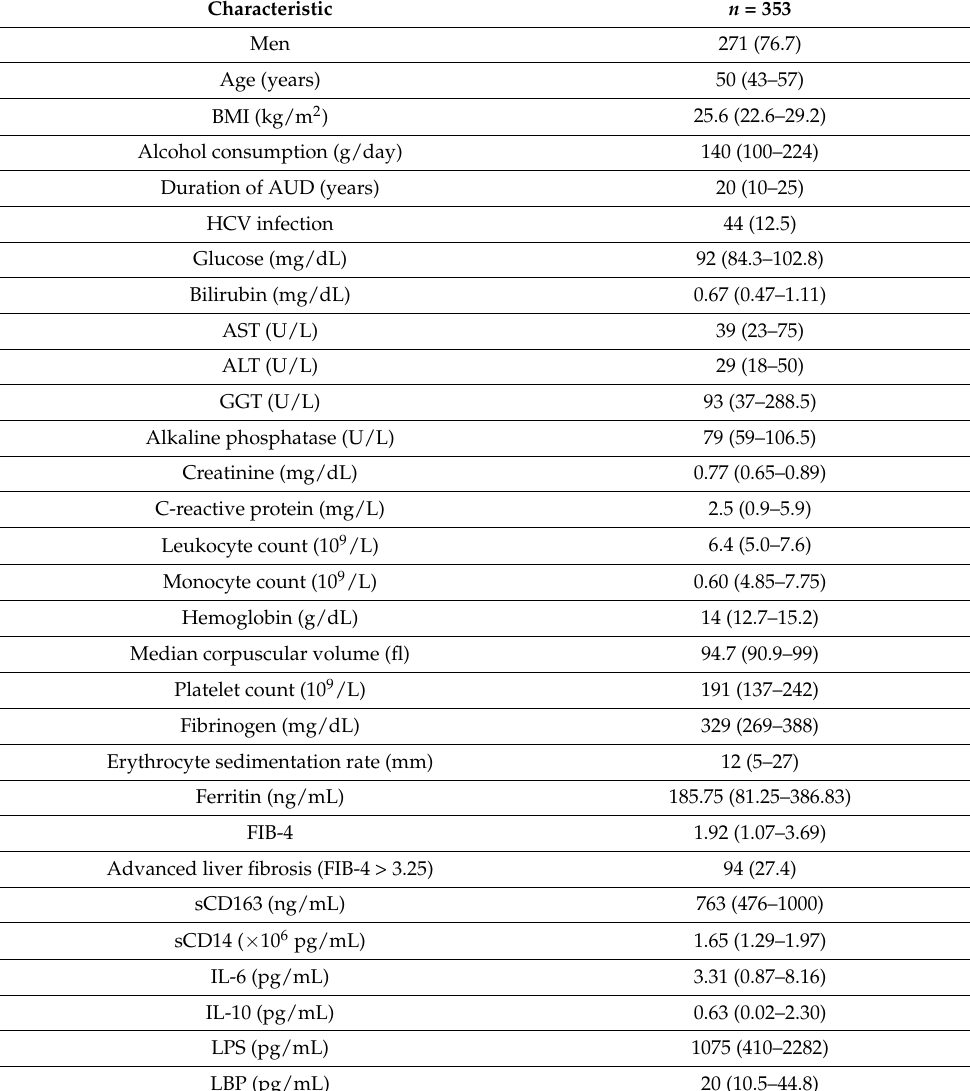
Table 1. Characteristics of the patients with alcohol use disorder admitted for hospital treatment.